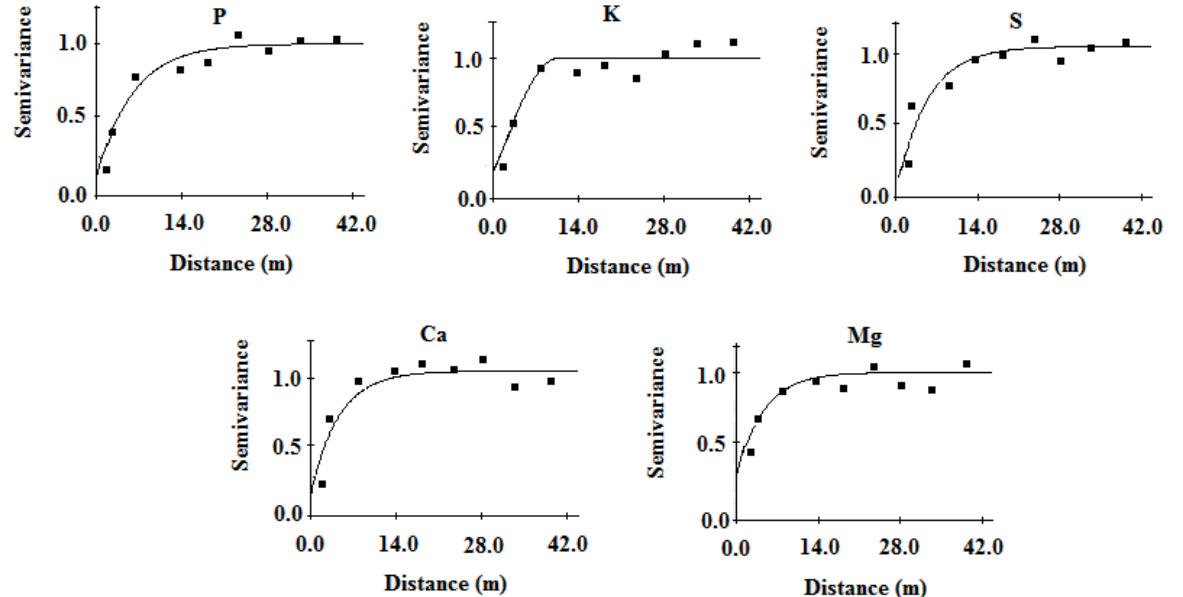
Figure 4. Standardized theoretical semivariograms for leaf macronutrients (P, K, S, Ca and